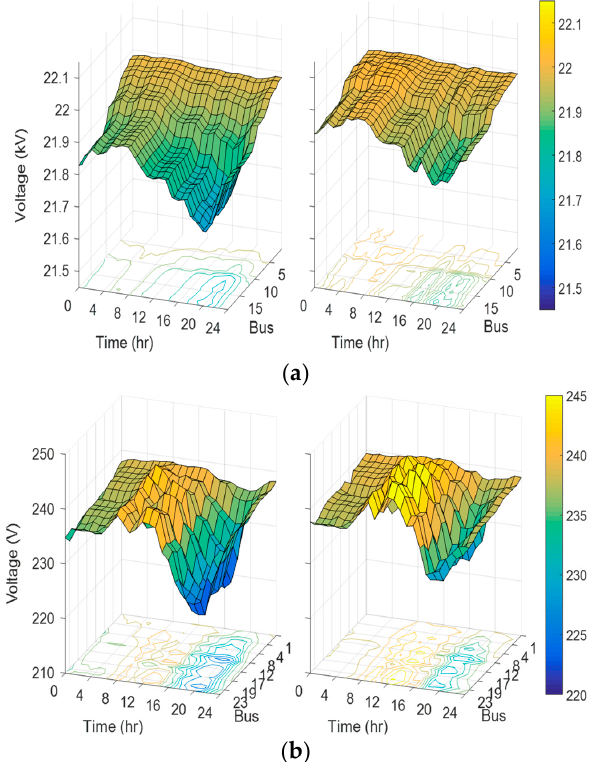
Figure 8. Voltage magnitude profile before and after the proposed control: ( a ) Line-BC voltage on the MV feeder; ( b ) phase-C voltage on the LV feeder.